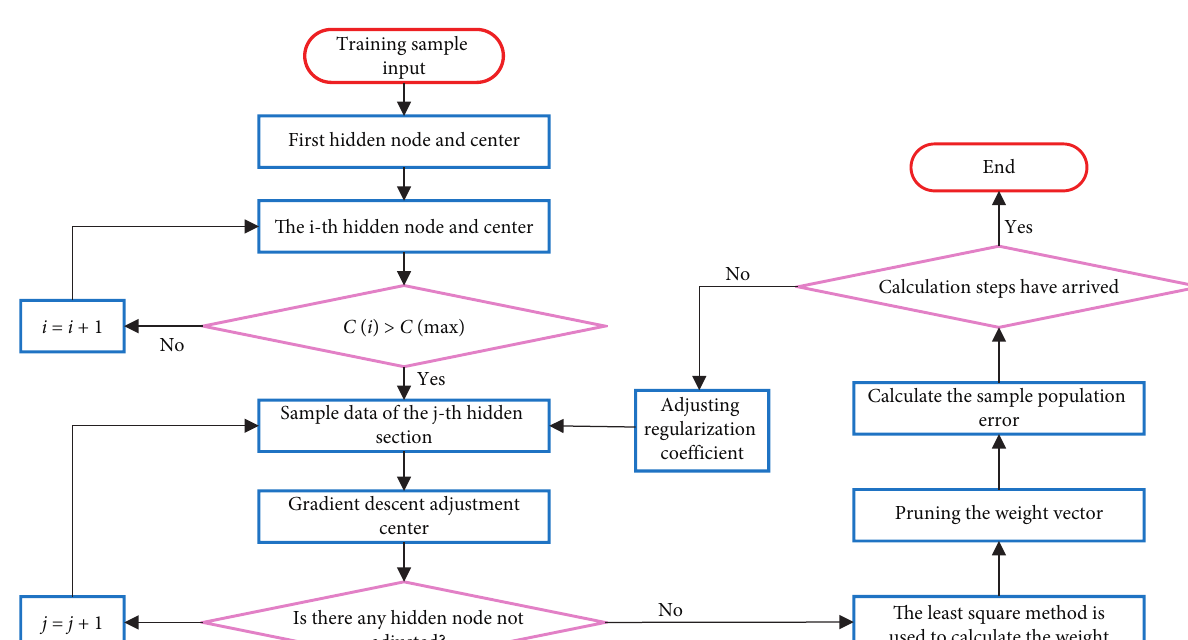
Figure 5: Network discomfort.